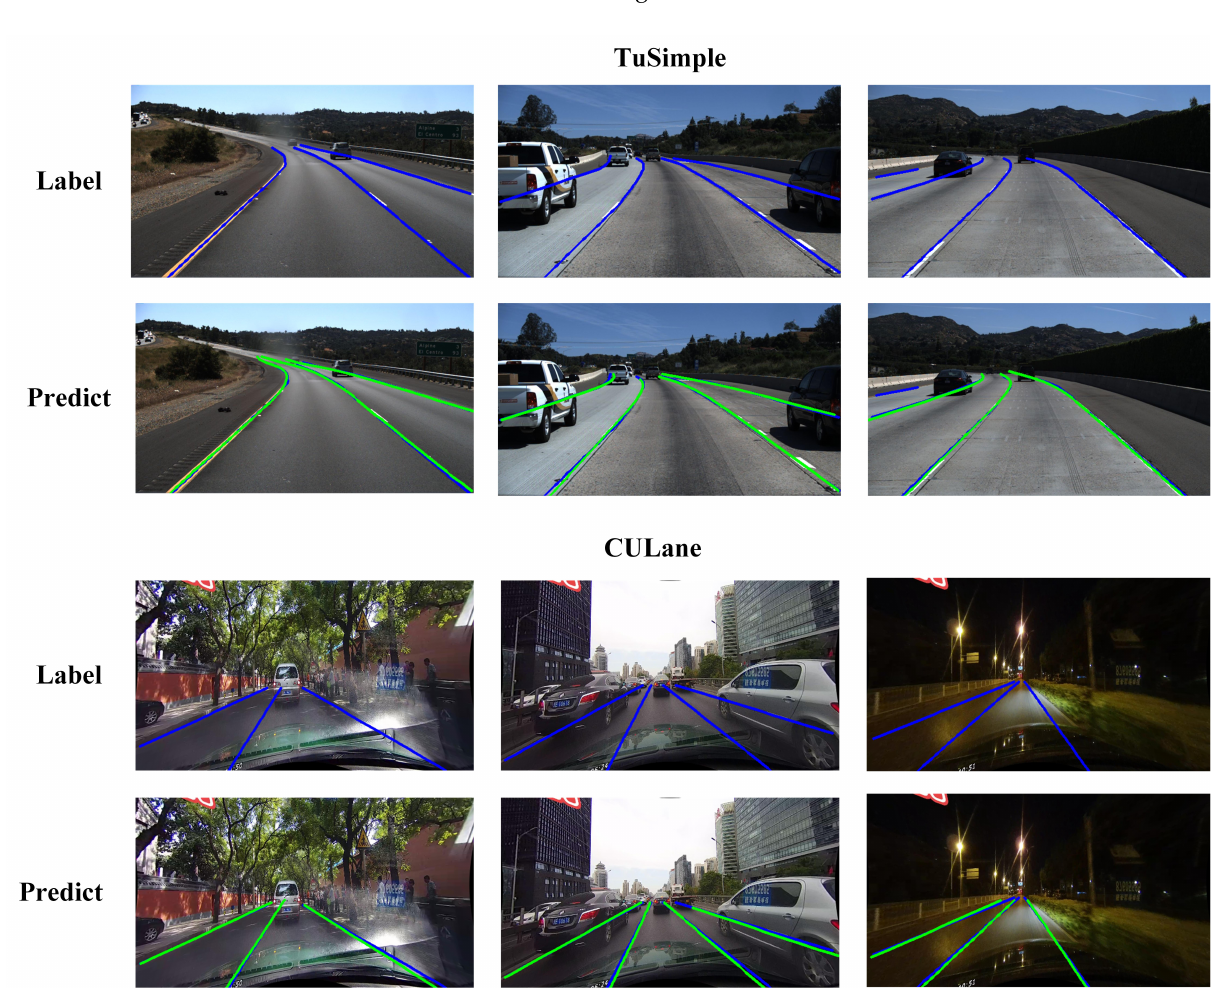
Figure 6. Visualization results on TuSimple (top two rows) and CULane (middle two rows). Blue lines are ground-truth and green lines are